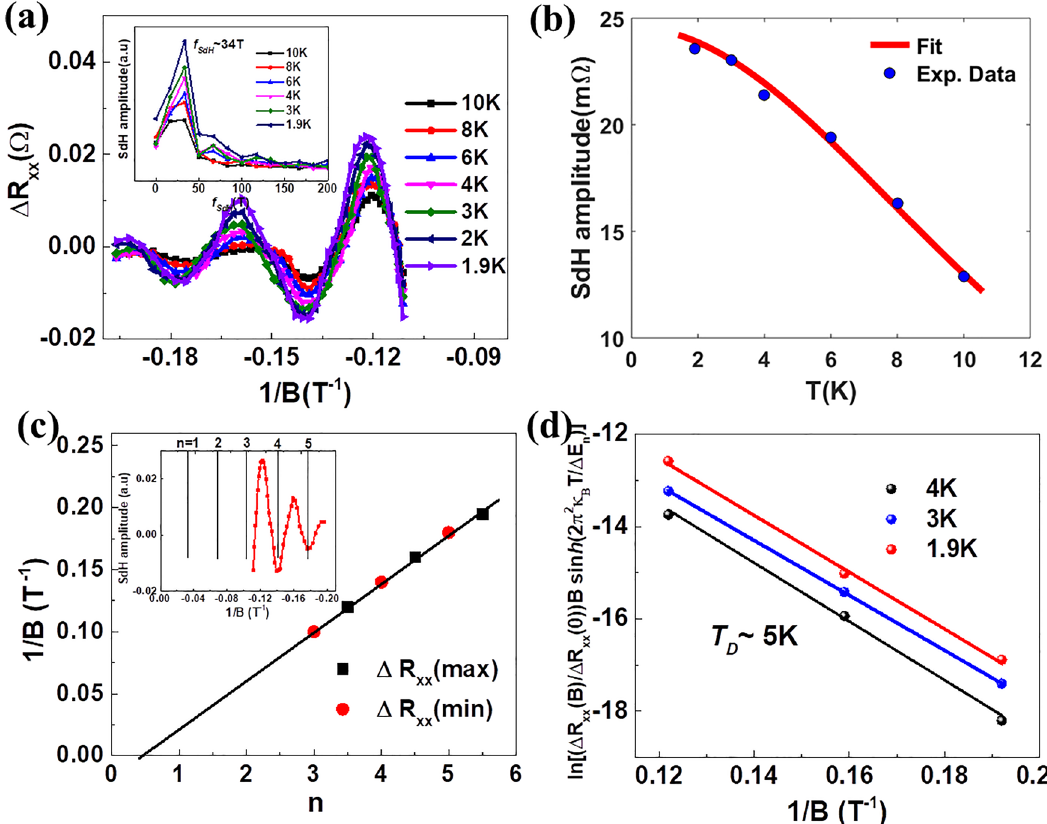
Figure 4. Lifshitz-Kosevich analysis of SdH oscillations: ( a ) The SdH oscillations in resistance data after background subtraction as a function of 1/B in temperature range 1.9–10 K. Inset shows the corresponding FFT spectra. ( b ) Standard L-K fit of temperature dependent SdH amplitudes. ( c ) The Landau level fan diagram of SdH maximas and minimas. Inset shows the Landau level assignment to SdH data at 1.9 K. ( d ) Dingle plots at 1.9 K, 3 K and 4